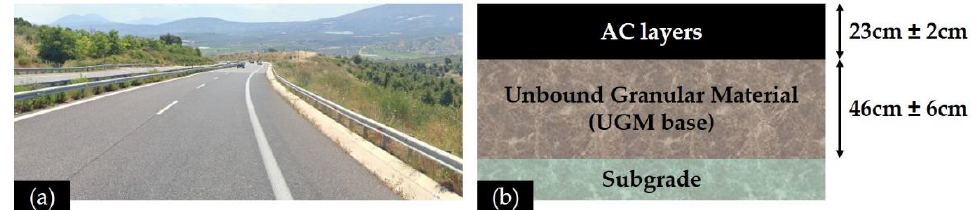
Figure 4. ( a ) Test site, and ( b ) typical pavement cross-section.